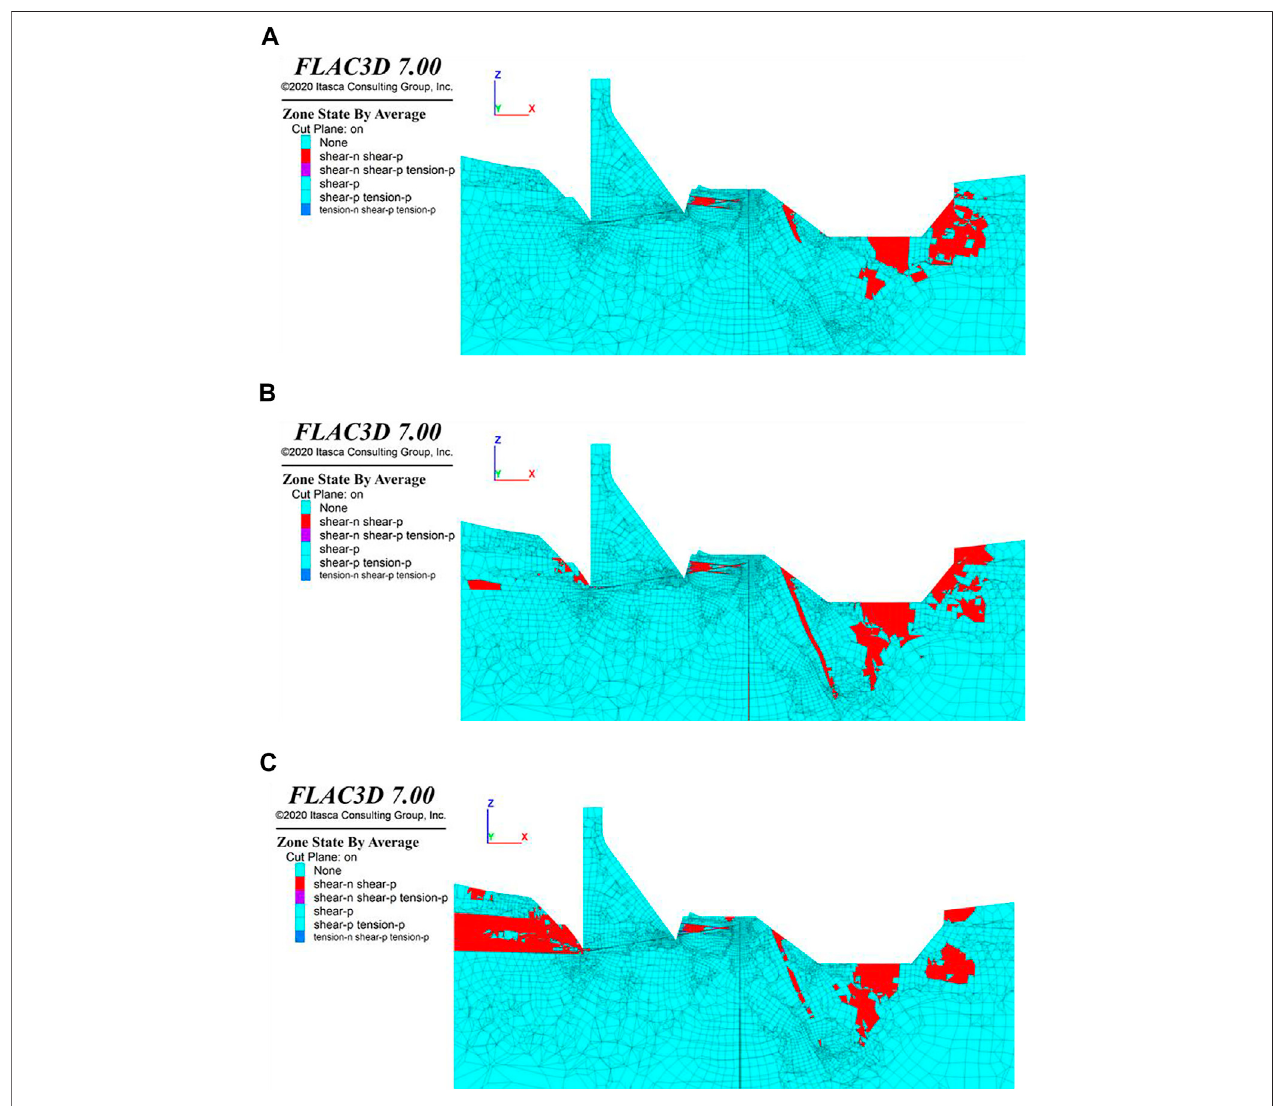
FIGURE 11 | Plastic zones in the pro fi le cutting through the center of dam section 3 under the conditions of (A) SRF = 2.0, (B) SRF = 2.2, and (C) SRF = 2.5.